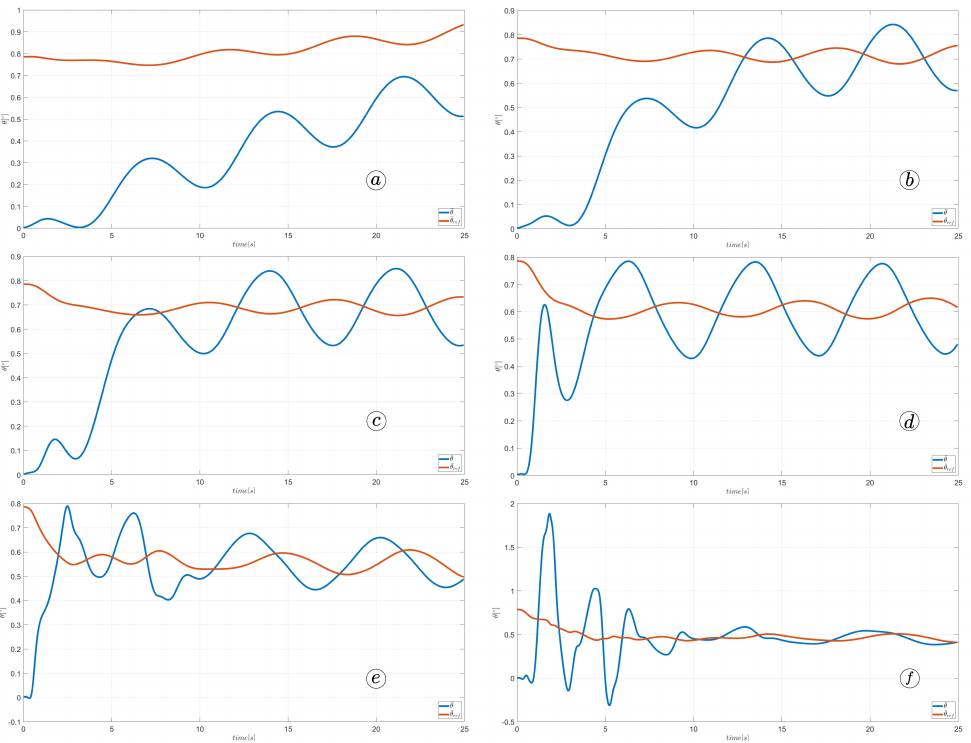
Figure 41. Heading angle and reference heading angle for k θ = 0.1 ( a ), k θ = 0.3 ( b ), k θ = 0.5 ( c ),